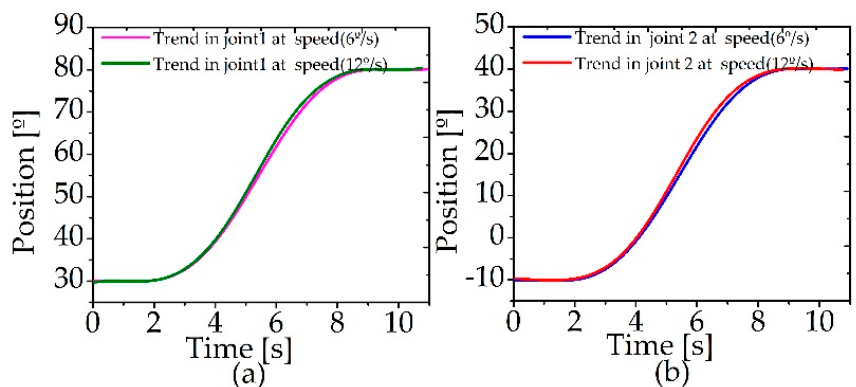
Figure 13. Encoder signal in both joint 1 and joint 2 with two speeds in the experiment. ( a ) The trend in joint 1 at two speeds, ( b ) the trend in joint 2 at two speeds.